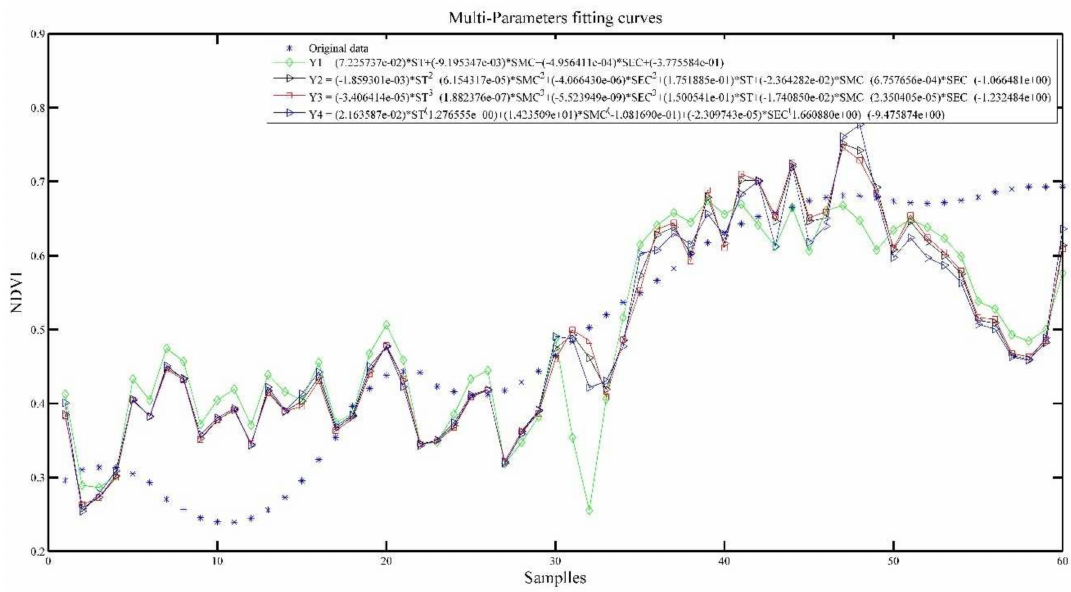
Figure 10. IMP and NDVI model